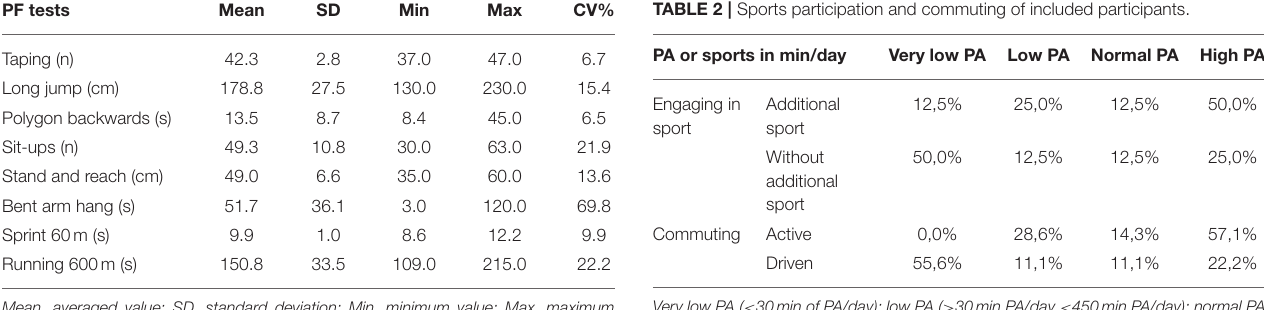
Frontiers in Public Health |